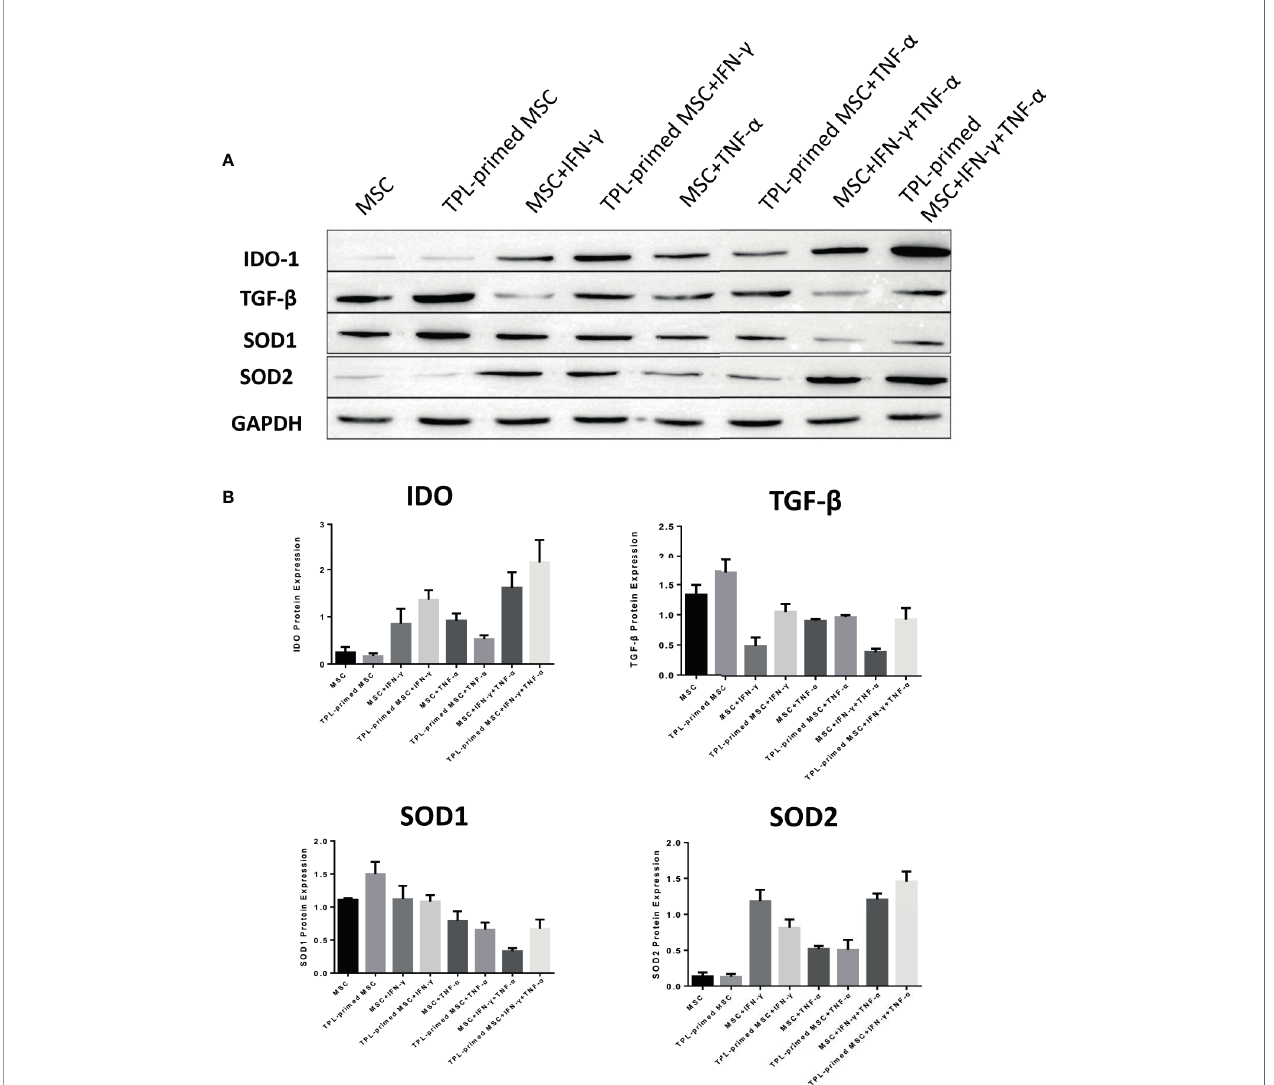
FIGURE 5 | Protein expression in TPL-primed or non-primed UC-MSCs in the presence of IFN- g and/or TNF- a . (A) The protein expression of IDO-1, TGF- b , SOD1, and SOD2 in TPL-primed UC-MSCs and non-primed UC-MSCs in response to IFN- g and TNF- a by western blotting. The representative data of three independent experiments are shown. (B) Quantitative data corresponding to GAPDH expression are presented as the mean value of three different samples ± SD with the P value tables ( Supplementary Figure S2